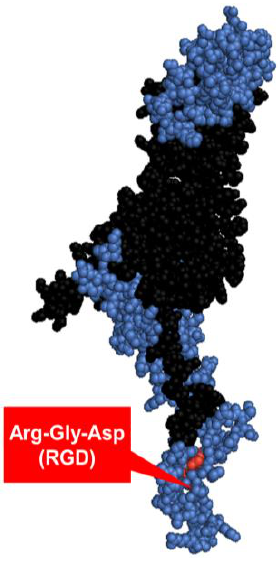
Figure 4. The Ad2 penton base monomer. The three main antigenic sites [57] are highlighted in blue, integrin-binding motif Arg-Gly-Asp (RGD) labelled in red [56,58]. The structure was constructed in PyMol version 1.1eval (PDB ID: 1X9P).